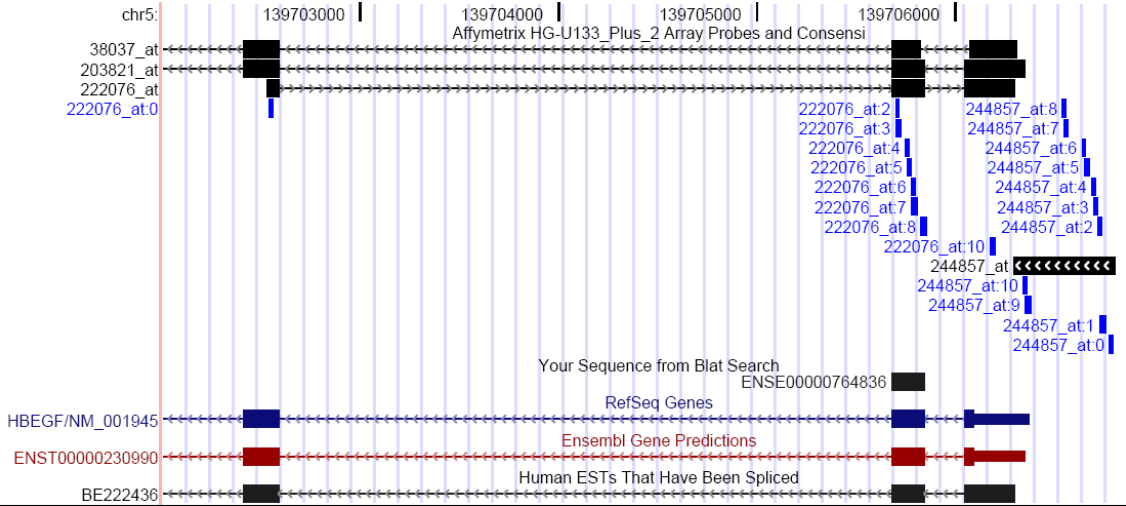
Figure 3. Screen-shot of the UCSC browser [19] shows that the probes in the probeset 222076_at are on the positive strand and exon ENSE00000764836 (in ENST00000230990) is on the negative strand. There are no transcripts aligning to the positive strand in this